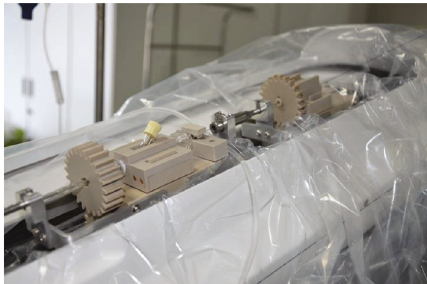
Figure 2: The manipulator arm of the slave end holding the guidewire.